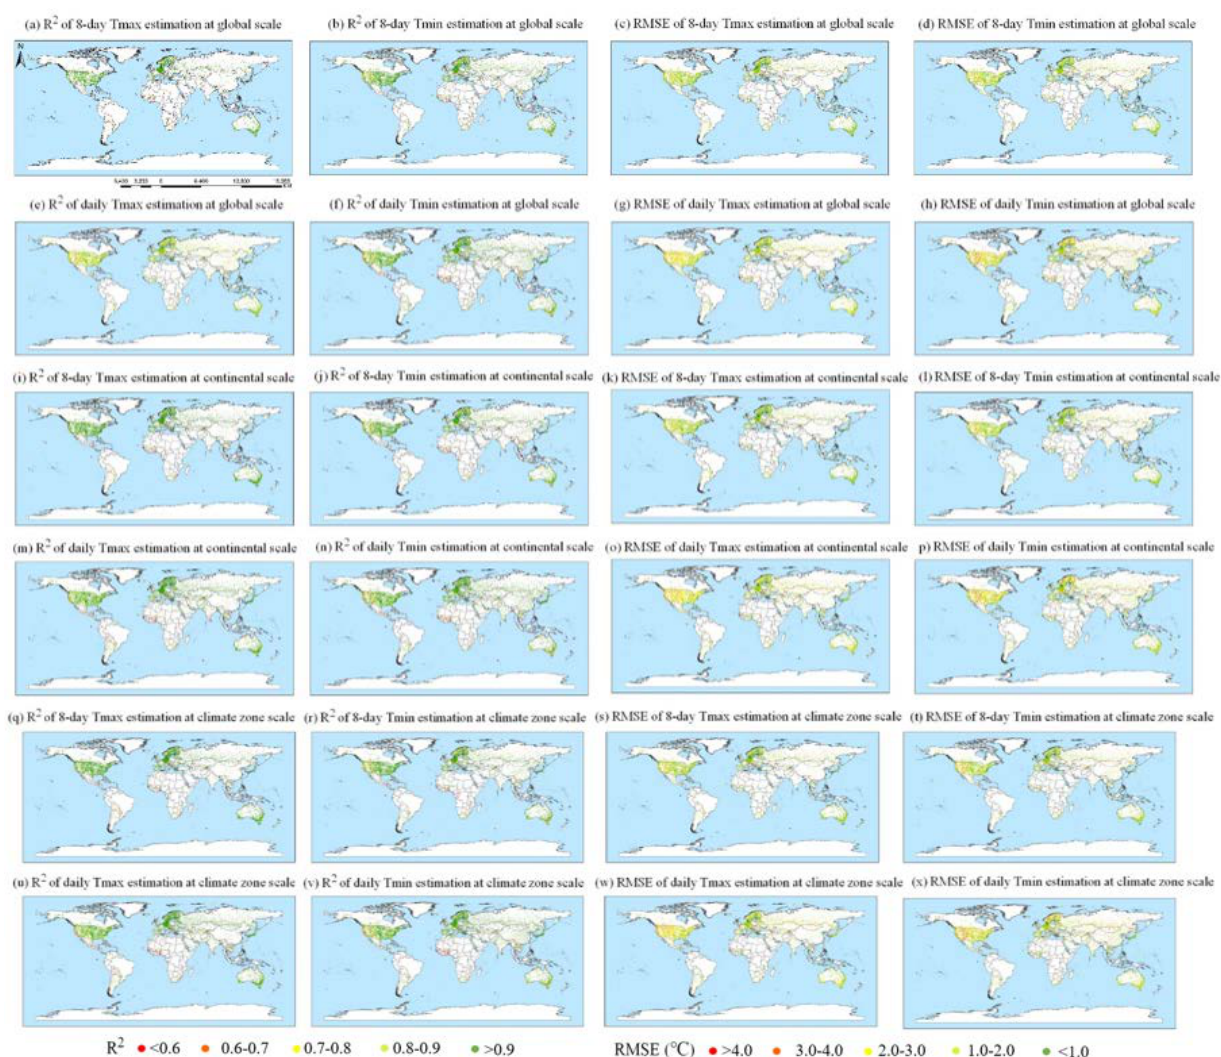
Figure 6. Spatial patterns of the 8-day and daily Tmax and Tmin estimation model performance at the different spatial patterns in spatial experiments.